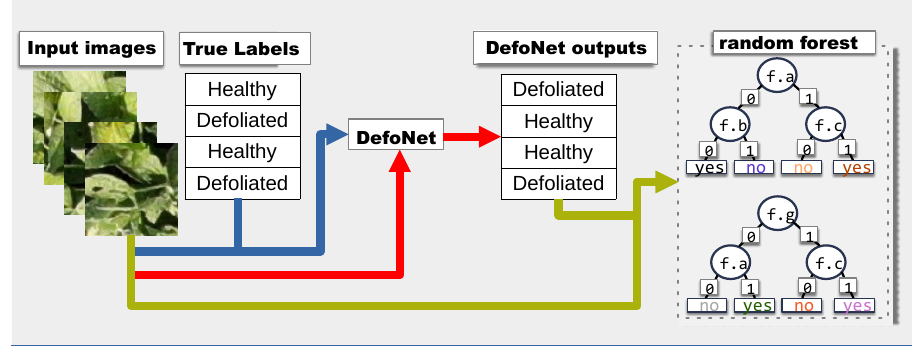
Figure 1. Overview of our approach. Images and the expert labels are used to train Defonet. Then, the same images are given to DefoNet to generate new labels. A random forest is trained with those images and DefoNet’s